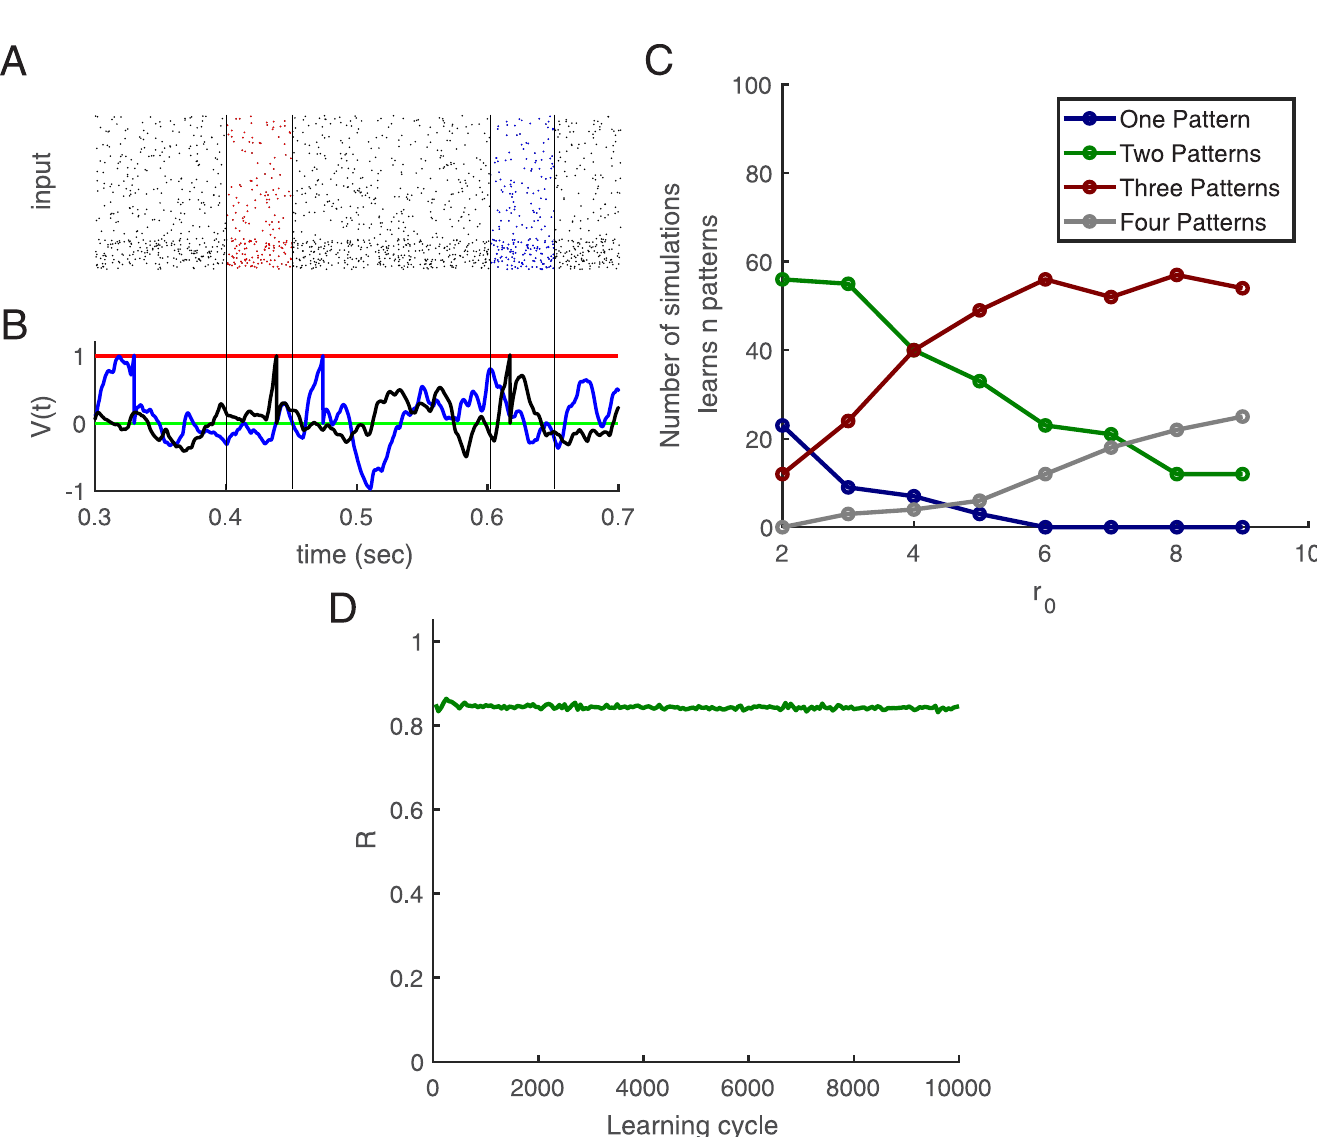
Fig 8. Learning more than one embedded pattern. (A) Input activity in the raster plot, five hundred afferents (80% excitatory and 20% inhibitory) send inputs to one post-synaptic neuron. The excitatory neurons’ rate is 5 Hz, and the inhibitory neurons’ rates are 20 Hz. There are two random embedded patterns of length 50 ms in the red and blue areas (between black vertical lines), r 0 = 4 Hz, and the length of the training epoch is 1000 ms. (B) Membrane potential versus time. The black trace shows that after learning the neuron responds to both embedded patterns. The green line is for resting potential, red is for threshold, blue is for before learning, and black is for after learning. (C) During learning, all embedded patterns are in the epoch, and we compute the percentages of neurons that can detect only one of the patterns (blue), two (green), three (red), and four of them depending on the target rate r 0 . This figure is based on an average of 100 simulations with 500 afferents. The training epoch is 1000 ms, L = 50 ms, L = 15 ms. (D) First, the neuron learns two embedded patterns, and then R as a memory criterion vs. learning cycle is em computed: Learning continues without learned patterns in afferents, and every 50 cycles, learning is paused, and the learned patterns are placed in the background, then R is computed as a memory criterion. There are two 50 ms embedded patterns, shown in afferents starting from 400 ms and 800 ms, L = 15 ms, and this figure is based on an average of 500 simulations. r 0 = 4